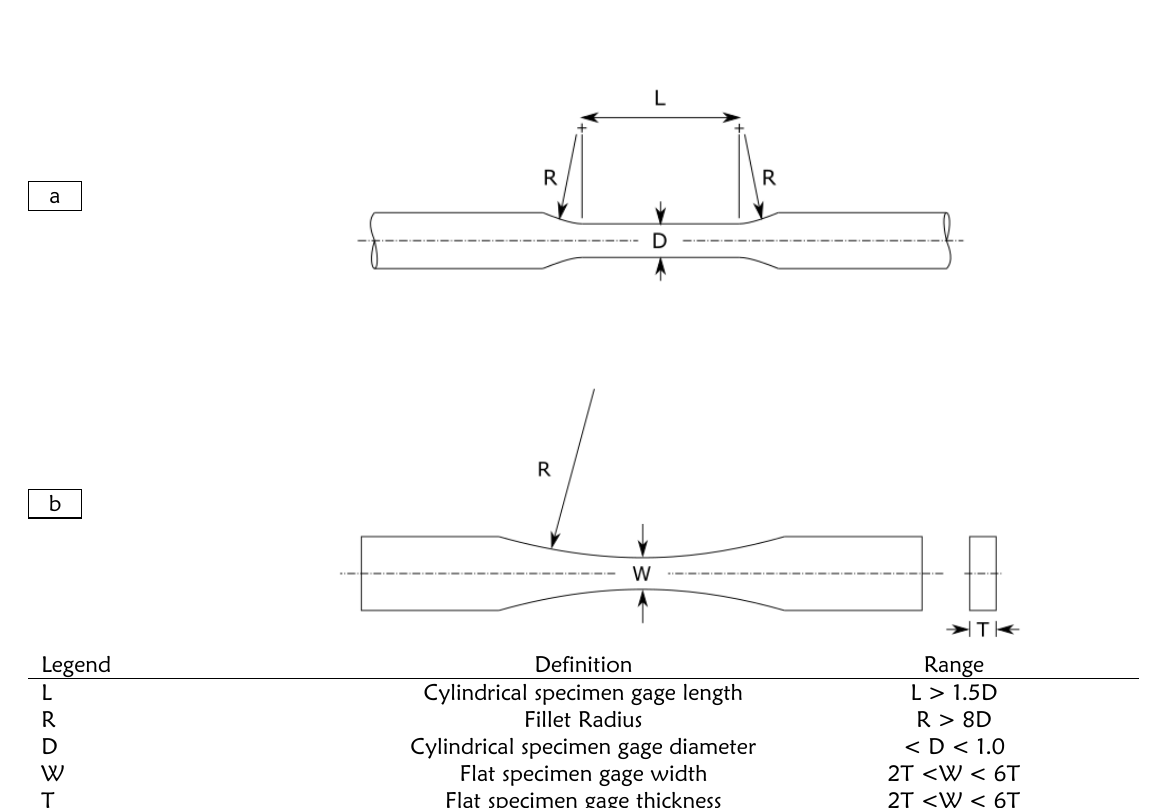
Figure 4: Common test specimen used in ASTM E466 standard (a) Specimens with tangentially blending fillets between the test section and the ends (b) Specimens with continuous radius between